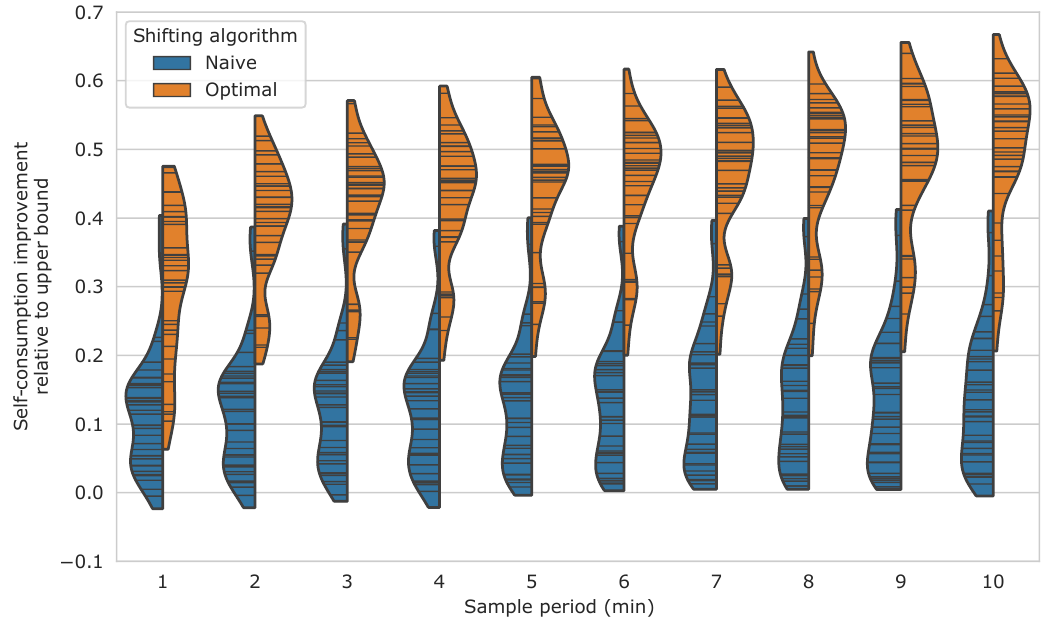
Figure 5. Distributions of the improvements from load shifting grouped by load shifting algorithm and sampling rate. Blue and orange areas relate to the naive and optimal algorithm respectively. The distribution values are normalized by the corresponding upper